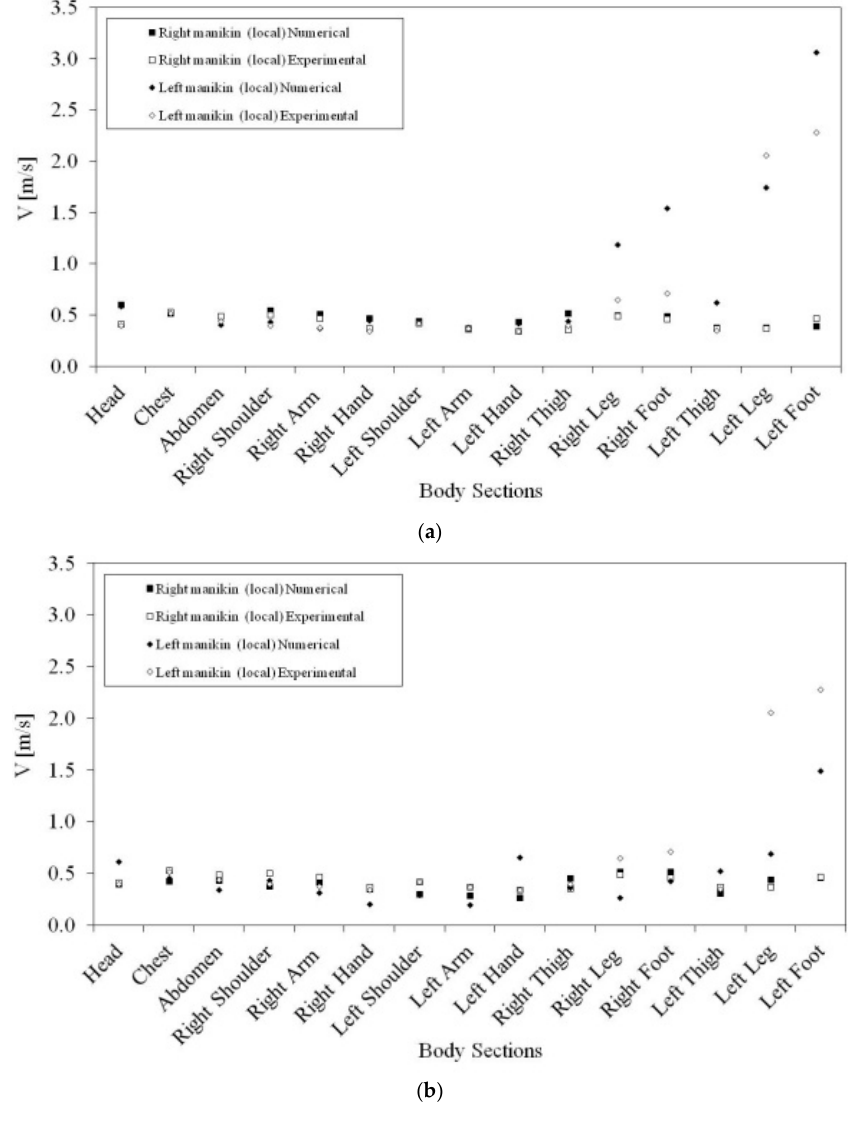
Figure 6. Air velocity value around the occupants seated on the right and left side, numerically calculated and experimentally measured. In ( a ), the k-epsilon turbulence model is used, and in ( b ), the RNG turbulence model is applied.